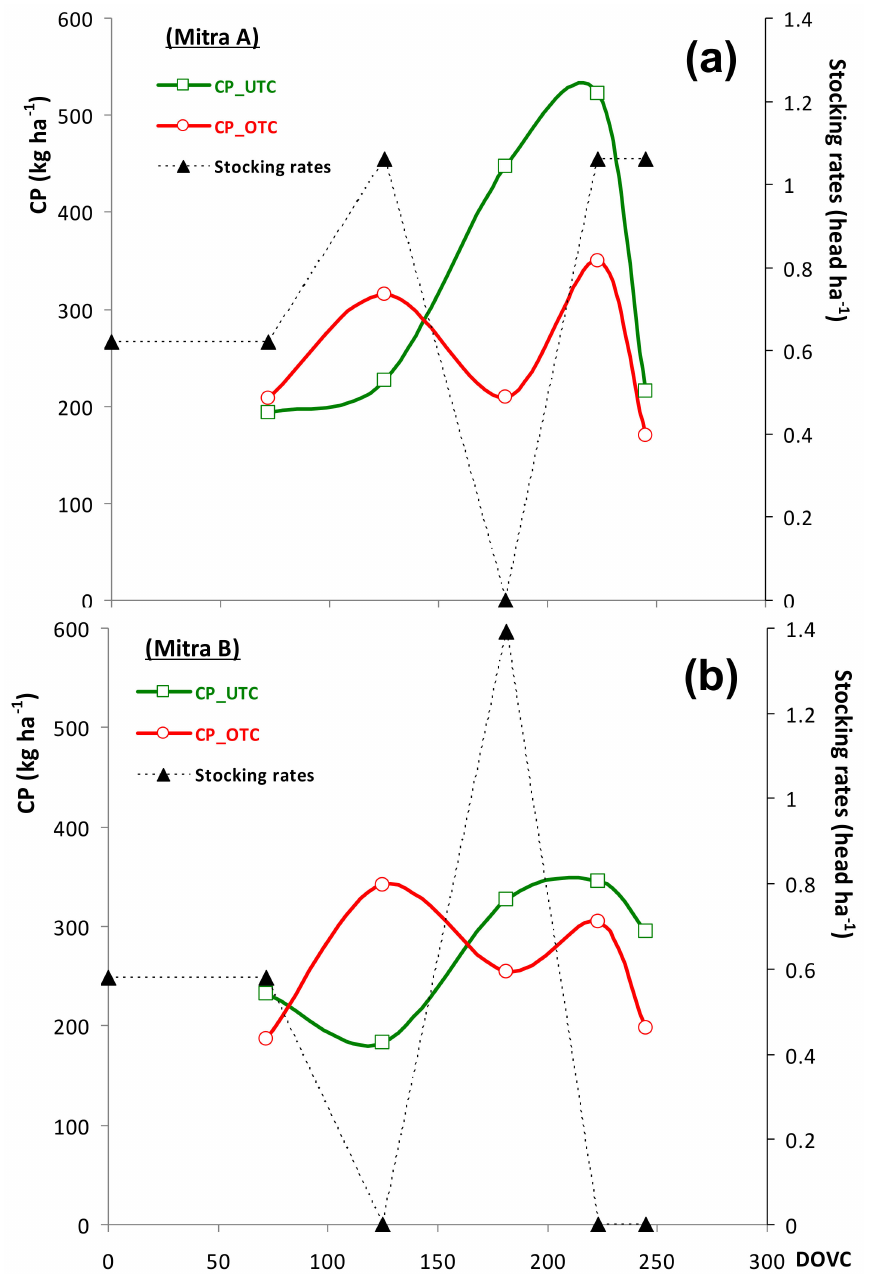
Figure 8. Evolution of the pasture productivity (crude protein, CP, kg ha − 1 ) throughout the vegetative cycle, in “Field A” ( a ) and “Field B” ( b ), under tree canopy (UTC) and outside tree canopy (OTC). DOVC, day of the pasture vegetative